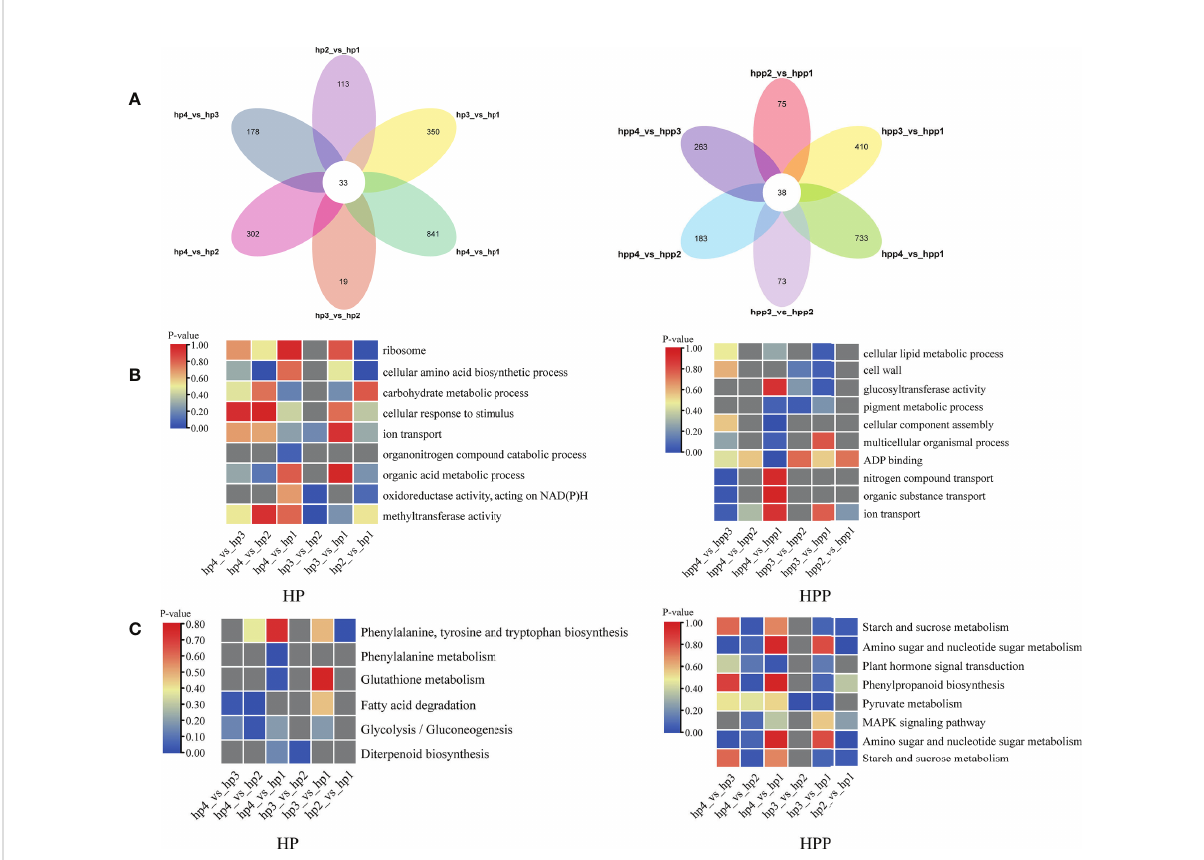
FIGURE 8 Venn analysis of differentially expressed genes (DEGs) over time in Harumi/Hongjv (HP) and Harumi/Ponkan/Hongjv (HPP) fruits. (A) Number of DEGs in the HP and HPP fruits. (B) Clusters of annotated Gene Ontology (GO) terms for DEGs in the HP and HPP fruits. (C) Kyoto Encyclopedia of Genes and Genomes (KEGG) pathway enrichment analysis of the DEGs in HP and HPP fruits. HP1, HP2, HP3 and HP4 represent HP at 45, 90, 135, and 180 DAF, respectively; and HPP1, HPP2, HPP3 and HPP4 represent HPP at 45, 90, 135, and 180 DAF, respectively. The signi fi cance of the most represented terms is indicated by the P -value. Signi fi cant and non-signi fi cant P -values are indicated in red and dark gray,